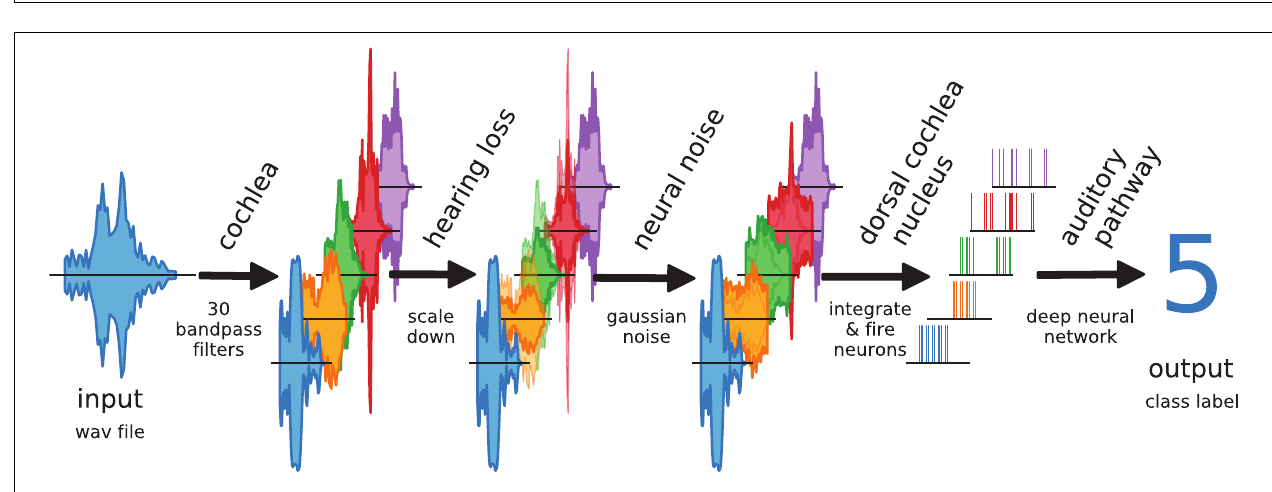
FIGURE 1 | Model layout. The complete model consists of three different modules representing different stages of the auditory pathway in the human brain. The input to the model are single words encoded as wave files with a sampling rate of 44.1 kHz and 1 s duration (A) . The cochlea and the spiral ganglion are modeled as an array of 30 band-pass filters (B) . The continuous output signal of (B) serves as input to 30 leaky integrate-and-fire-neurons representing the DCN (C) . The spike-train output of the DCN model is down sampled and serves as input for a deep neural network that is trained with error backpropagation on the classification of 207 different German words (D) . The classification accuracy serves as a proxy for speech recognition (E) . In order to investigate the effect of a particular hearing loss, the cochlea output amplitude is decreased by a certain factor independently for all frequency channels (F) . White noise representing somatosensory input to the DCN can be added independently to the input of the different leaky-integrate-and-fire-neurons (LIF, G ).